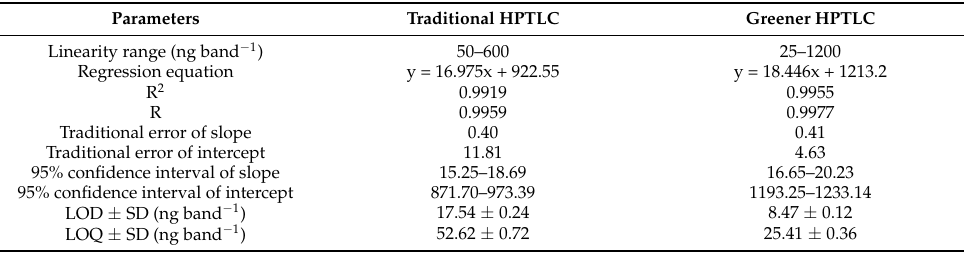
Table 1. Results for the linearity of vitamin D3 (VD3) for the traditional normal-phase high- performance thin-layer chromatography (HPTLC) and greener reversed-phase HPTLC methods (mean ± SD; n = 6). Parameters Traditional HPTLC Greener HPTLC